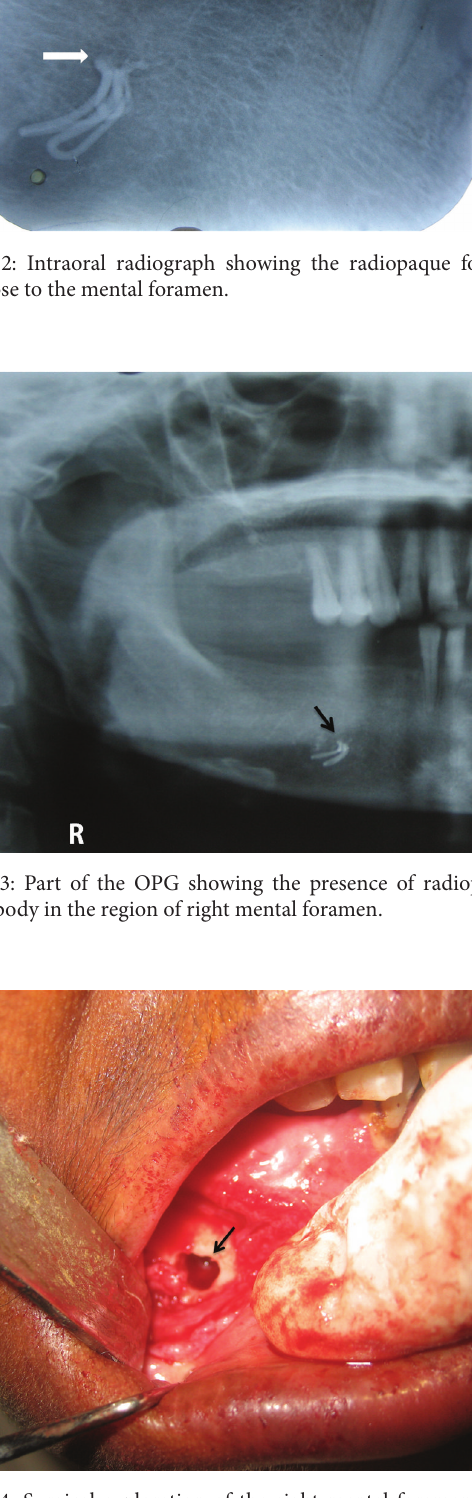
Figure 4: Surgical exploration of the right mental foramen done under local